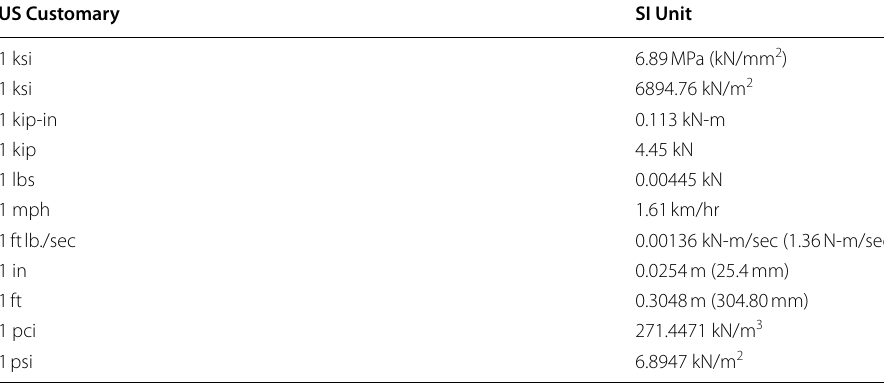
Table 6 Conversion chart for the US customary to the equivalent SI units US